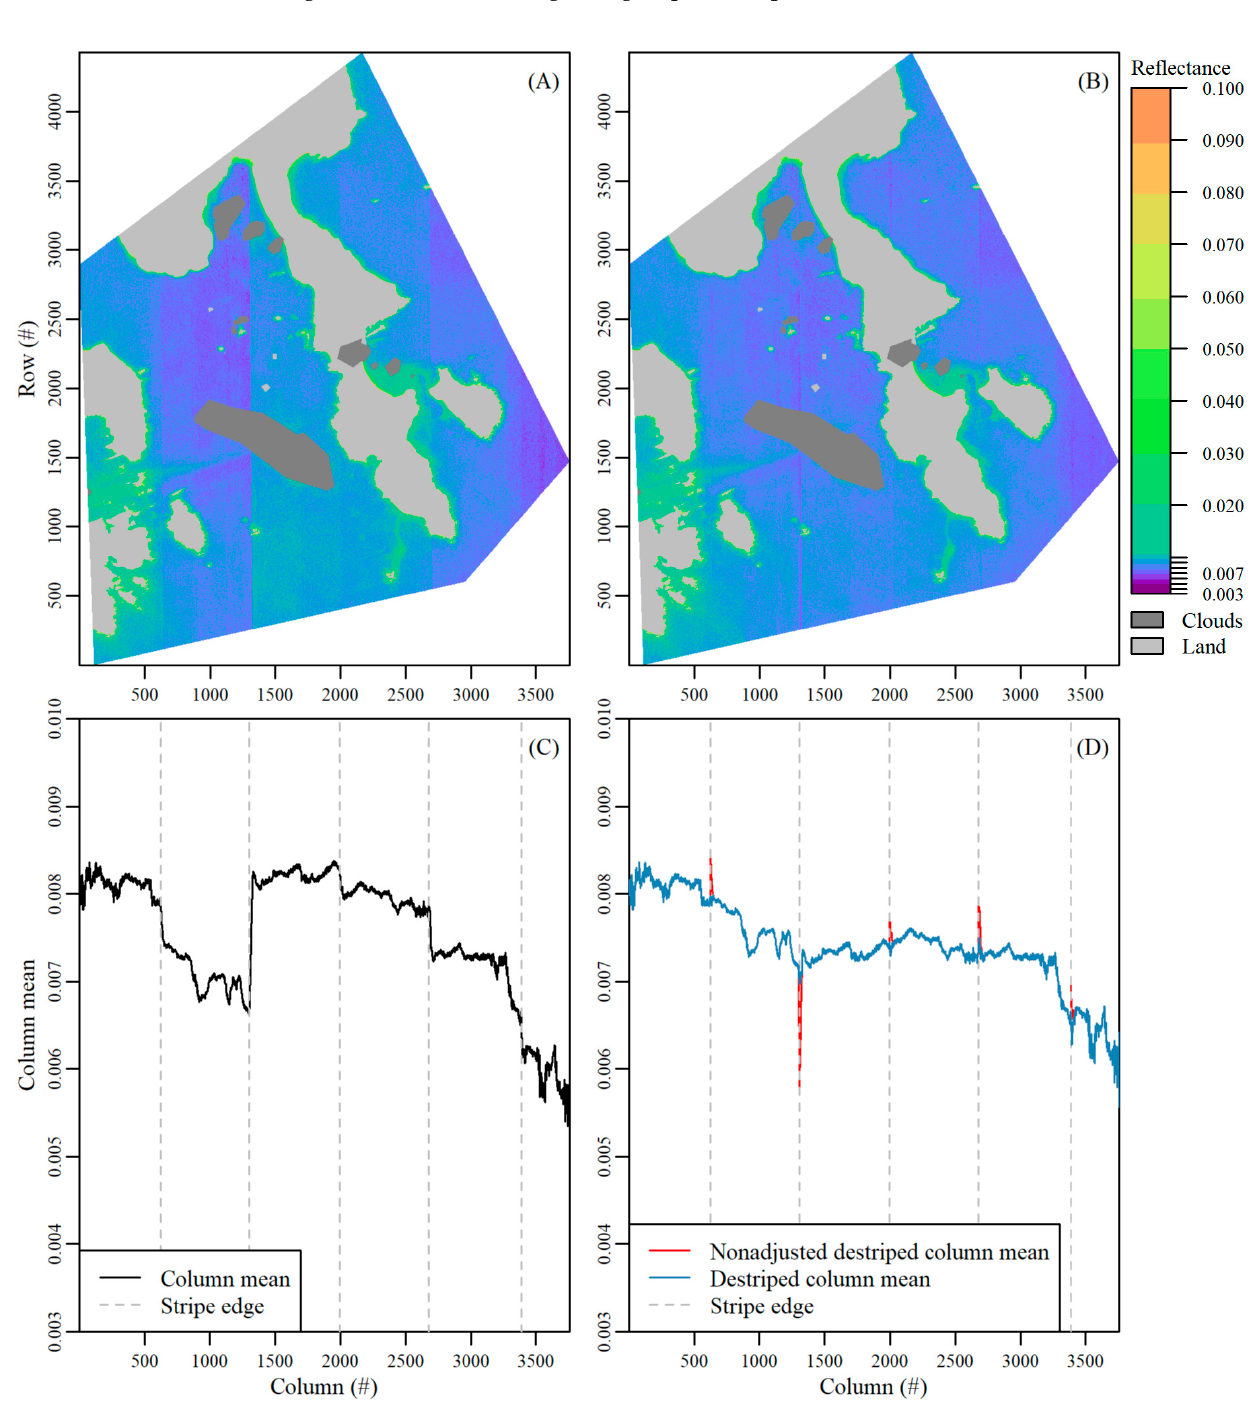
Figure 3. Example stripe correction using the red band (center wavelength 660 nm) for the 17 August 2019 WorldView-3 image. Surface reflectance for the image before ( A ) and after ( B ) the de-striping application. The column mean of the image before the de-striping application ( C ), indicating the location of stripes (edges indicated with light grey dashed lines). The column means were iteratively adjusted with an offset to remove the stripe effect ( D ).